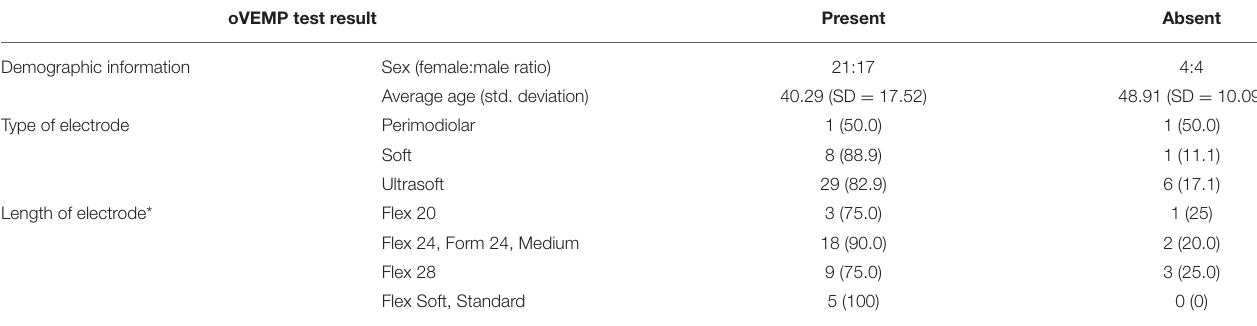
TABLE 2 | Postoperative oVEMP results.